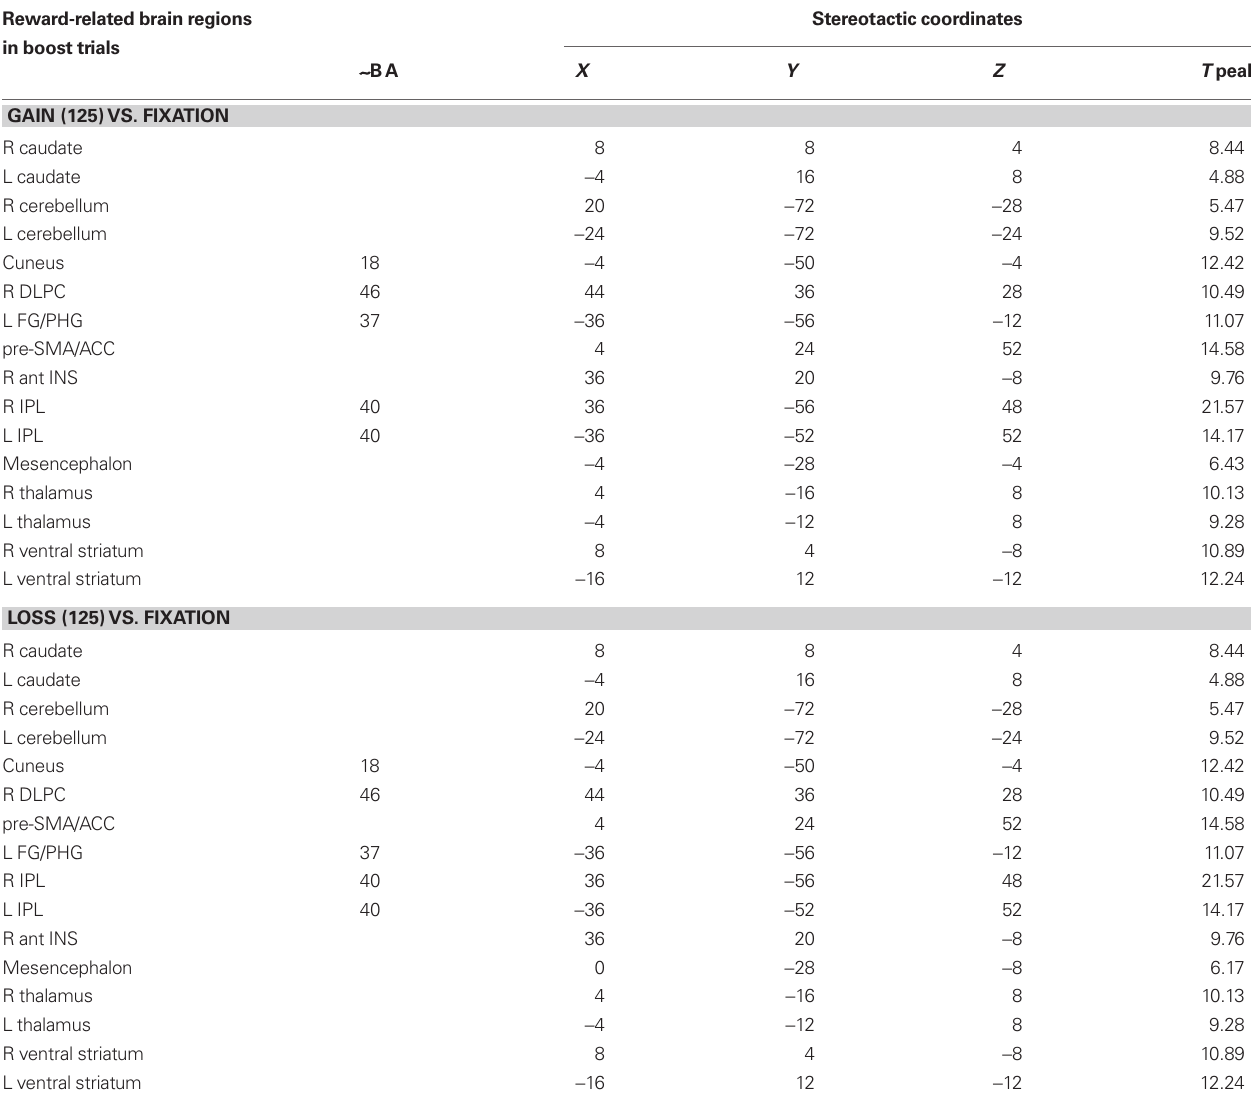
Table 1 | Main effects for gains and losses in the standard functional analysis for the boost trials. Reward-related brain regions Stereotactic